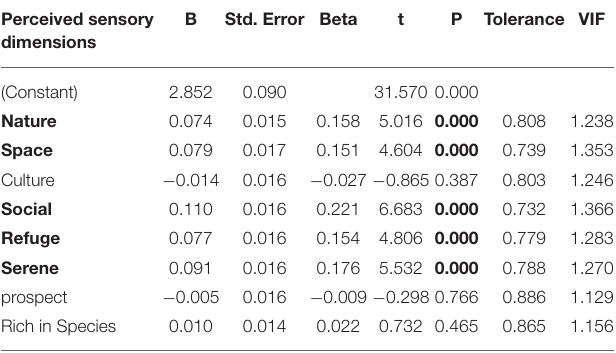
The highlighted bold factors represent significantly correlated